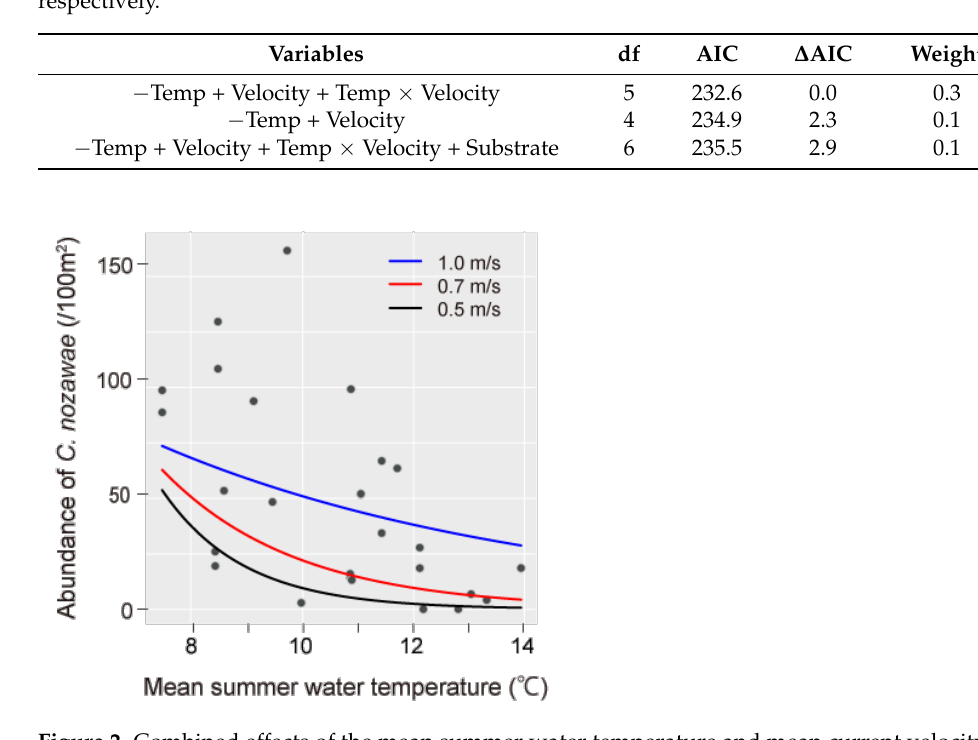
Figure 2. Combined effects of the mean summer water temperature and mean current velocity on the abundance of C. nozawae (n/100 m 2 ). The black circle indicates the observed value for each study site. The blue, red and black lines indicate the predicted values at high (1.0 m/s), moderate (0.7 m/s) and low (0.5 m/s) current velocities, respectively. These velocities correspond to the 10th percentile, median and 90th percentile,